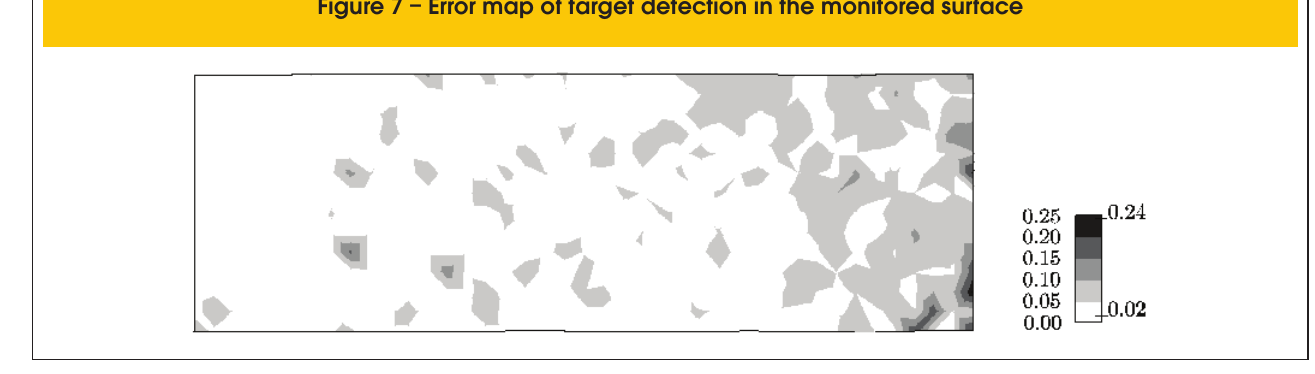
Table 1 – Vertical displacements in mm using LVDTs and photogrammetry (units in mm) Section 1.0 m at the left support Section at mid-span Section 1.0 m at the right support